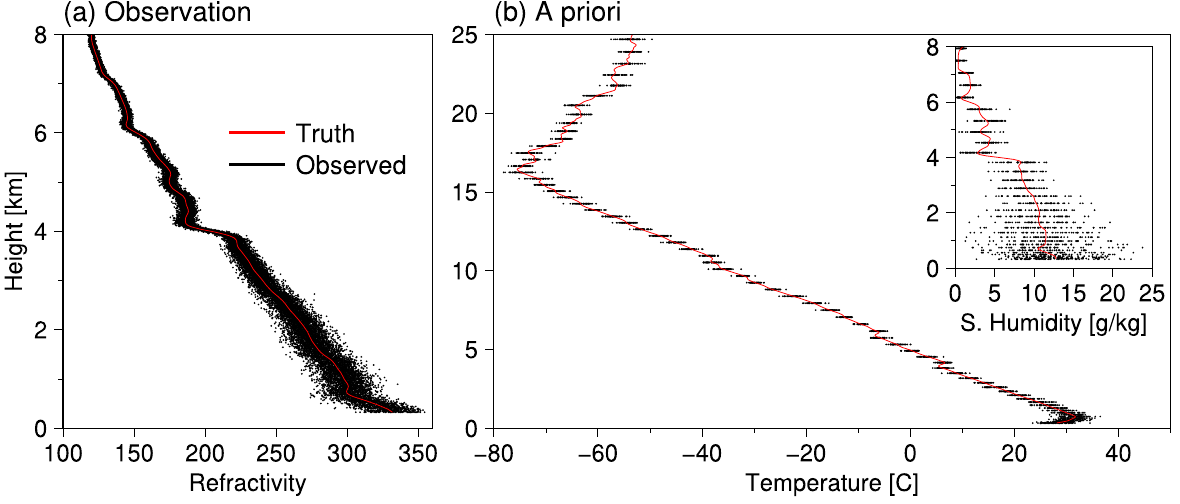
Figure 5. Synthetic 1D-Var input data for a subtropical case generated based on a GRUAN radiosonde observation and a collocated COSMIC profile. ( a ) The true atmospheric refractivity (red line) and assumed realizations of the observation (black dots). ( b ) Perfect, error-free a priori temperature and specific humidity (inset) profiles (red lines) and corresponding realizations (black dots). For visualization purposes only 50 realizations are shown. See text for details.